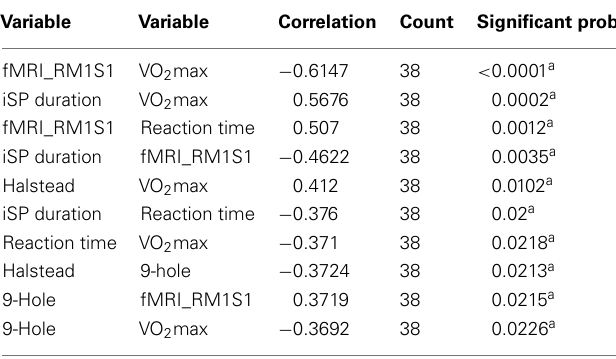
Table 7 | Significant pair-wise correlations of measures showing across middle age